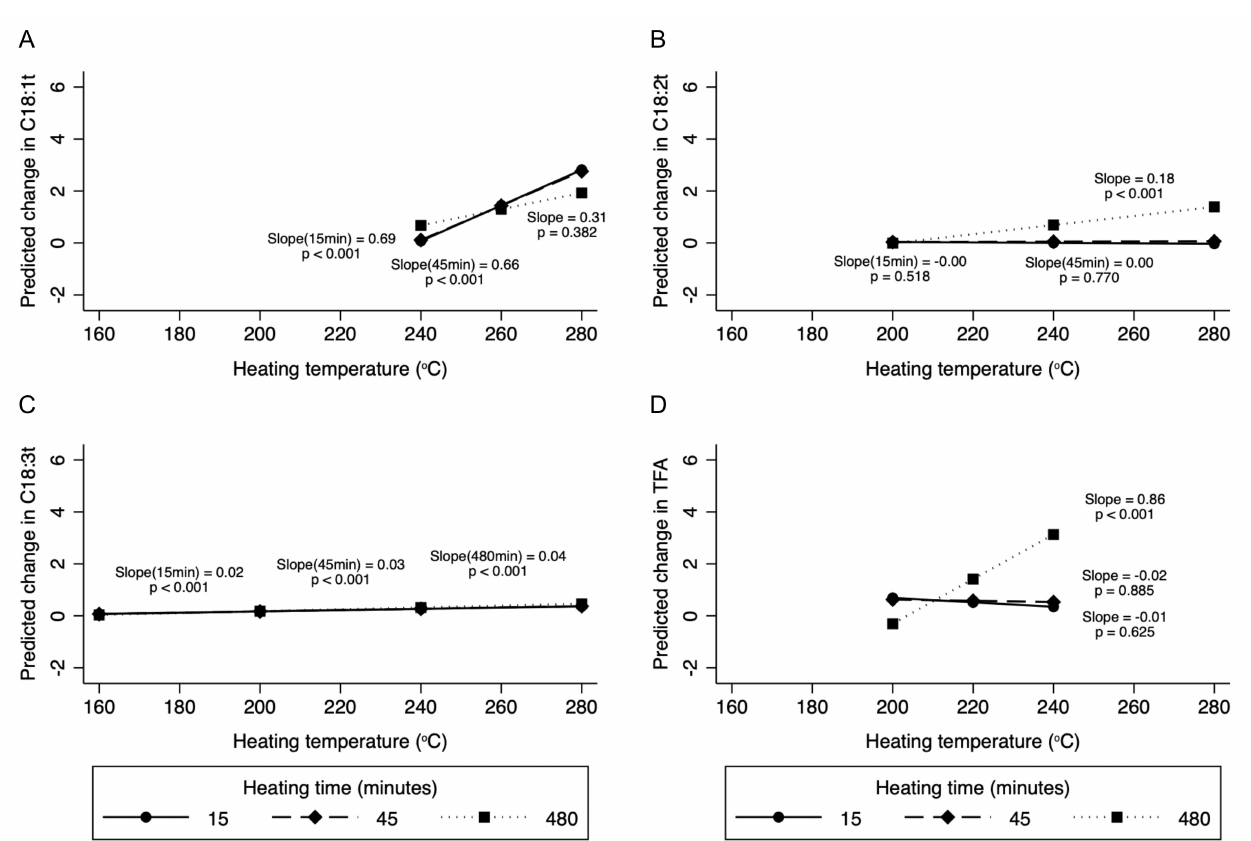
Figure 3. Margins plot demonstrating the interaction between heating temperature and heating time for various TFA. In subfigures ( A ), ( B ), and ( D ), the data label for 480 min is 0.31, 0.18, and 0.86, respectively, and in ( C ) it is 0.04. Data were fitted using mixed multilevel linear regression with intercepts for studies specified as random effects and splines at 200 and 240 ◦ C. Slopes represent change in C18:1t ( A ), C18:2t ( B ), C18:3t ( C ), and total TFA ( D ) per 10 ◦ C (% of total fatty acids)